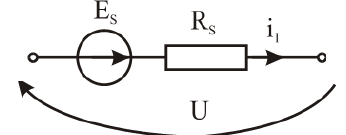
Figure 8. Equivalent circuit of IM.